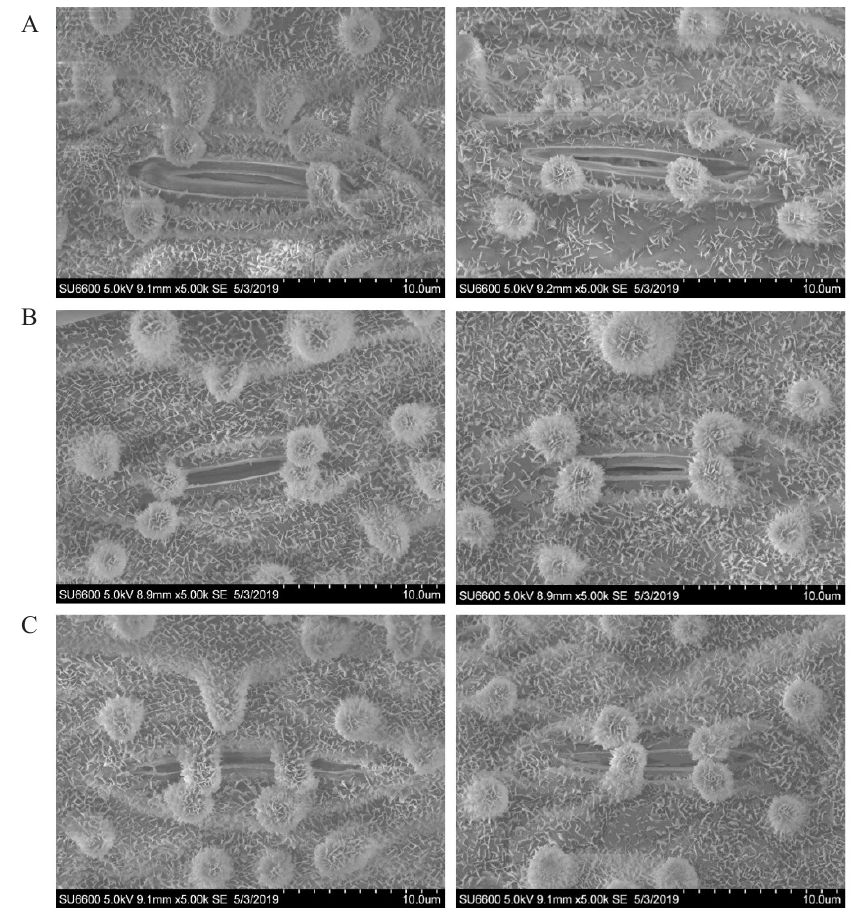
Figure 4: FE-SEM images of Adaxial and Abaxial surfaces and stomata of A) Bg94-1 B) Pachchaperumal and C) Suwandel.